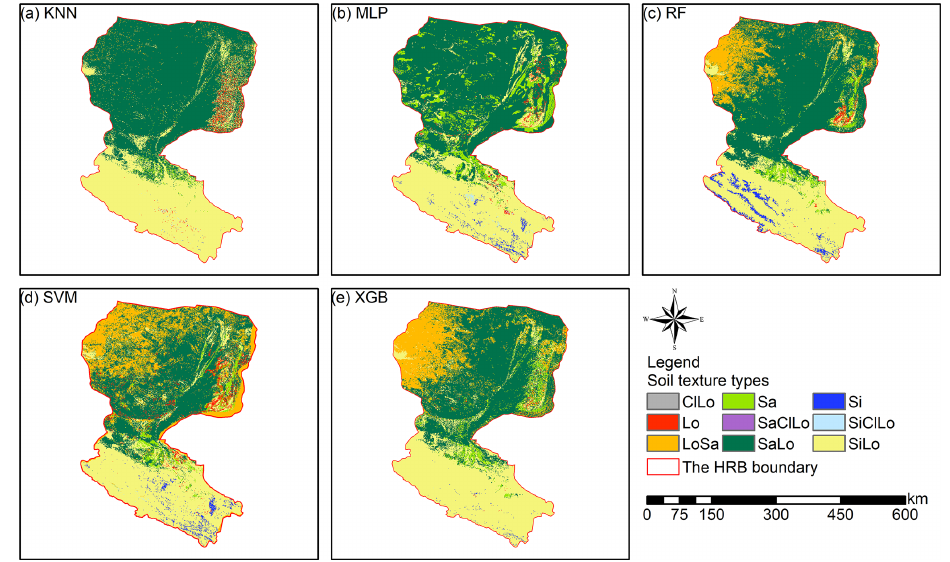
Figure 5. Soil texture classification prediction maps of different soil texture types for (a) KNN, (b) MLP, (c) RF, (d) SVM, and (e)